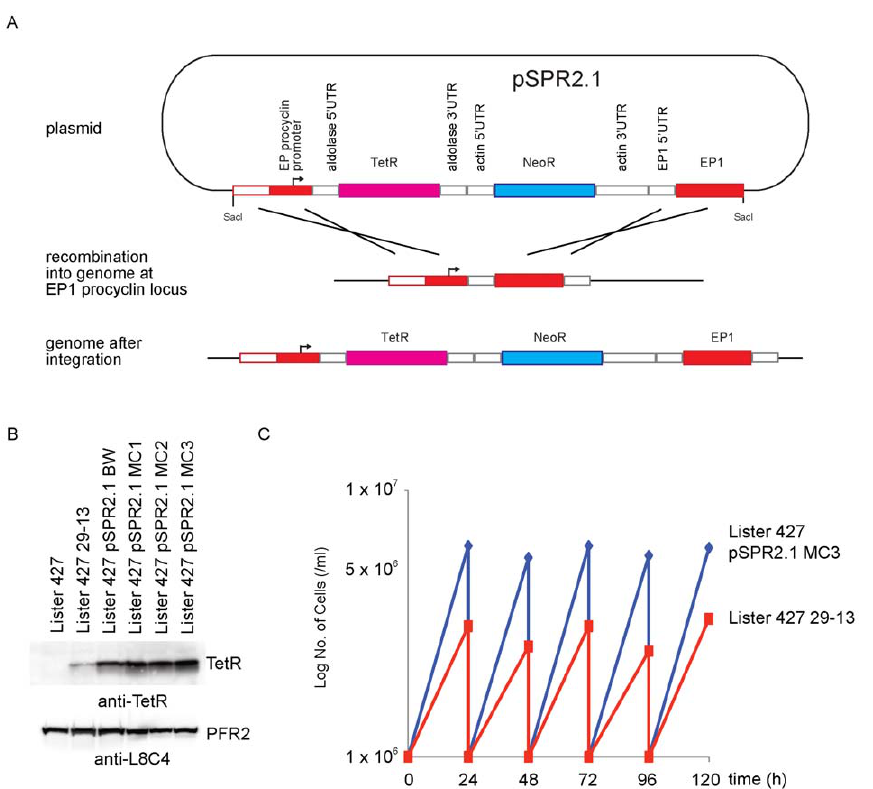
Figure 1. Comparison of the Lister 427 pSPR2.1 and Lister 427 29-13 cell lines. (A) Diagram showing pSPR2.1 and its integration after digestion with SacI. The plasmid integrates between the EP1-1 ORF and promoter. The protein coding regions are represented by the large rectangles. The intergenic regions are represented by the small rectangles and the origins of these regions are labelled above them. (B) Western blot probed with anti-TetR and anti-PFR (loading control) showing the levels of TetR expression in wild type, 29-13, and four independent SPR2.1 cell lines. (C) Comparison of growth of an SPR2.1 cell line and 29-13 cell line.